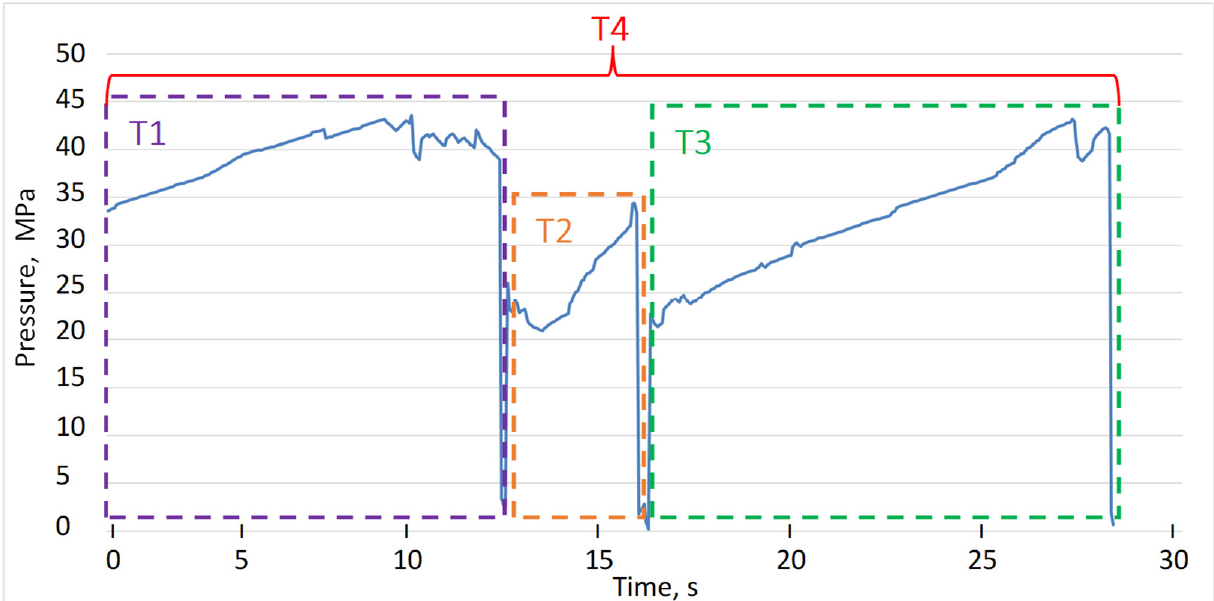
Figure 3. Recorded pressure during the rock mass shock that caused the rack to fail.